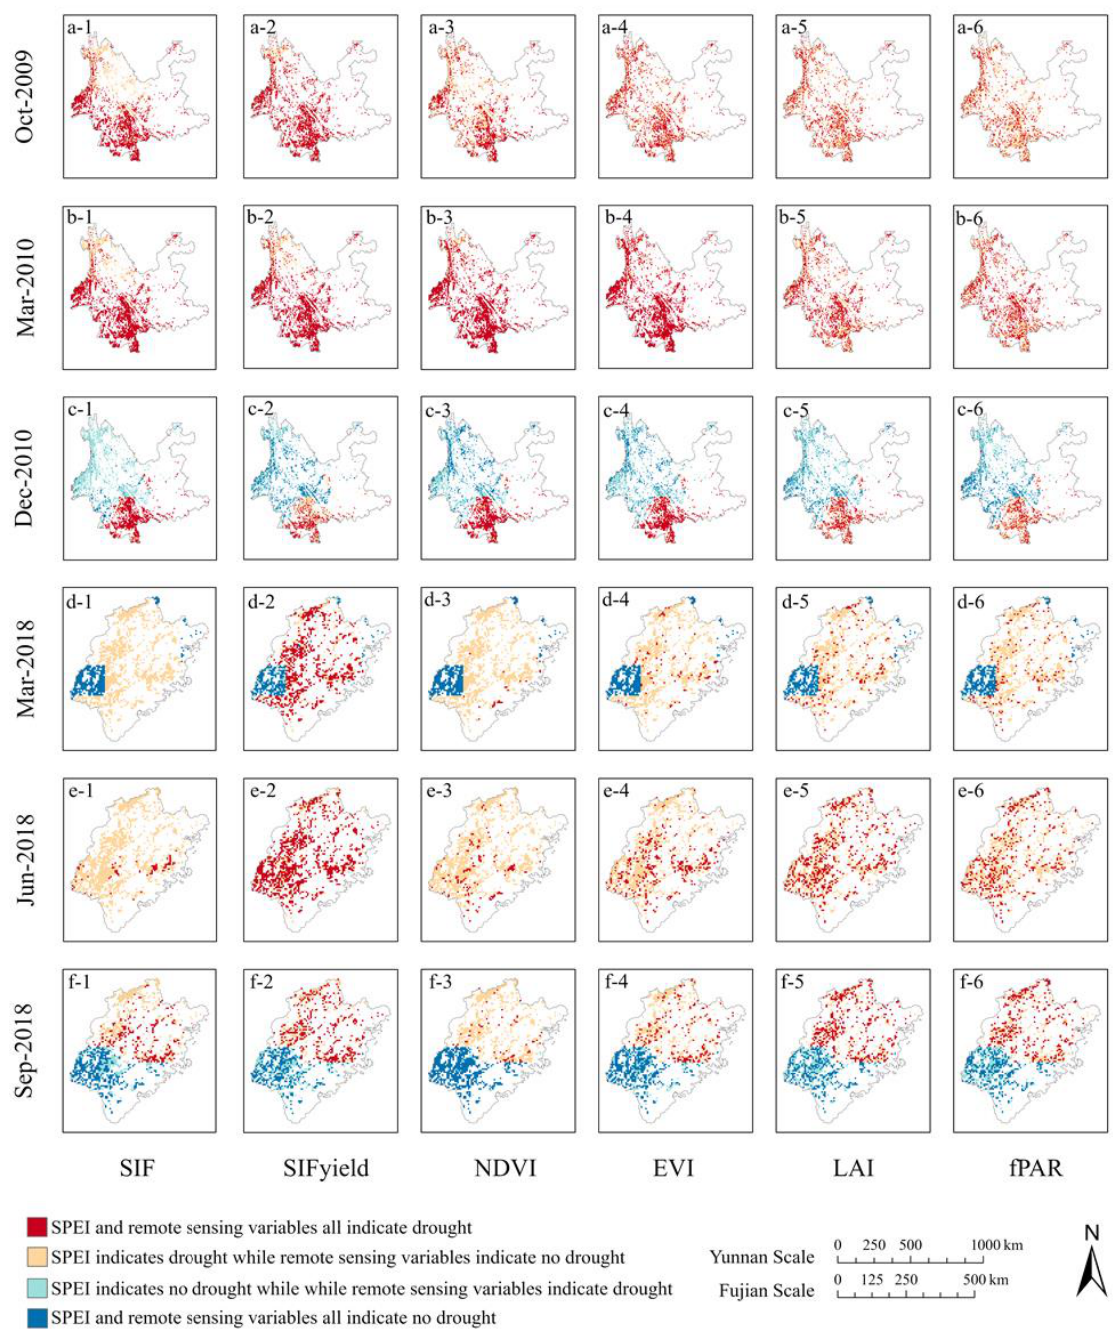
Figure 6. ( a1 – a6 ) The spatial distribution of standardized anomalies of SIF, SIFyield, NDVI, EVI, LAI, and fPAR in the early drought period in Yunnan province, respectively; ( b1 – b6 ) The spatial distribution of standardized anomalies of SIF, SIFyield, NDVI, EVI, LAI, fPAR in the middle drought period in Yunnan province, respectively; ( c1 – c6 ) The spatial distribution of standardized anomalies of SIF, SIFyield, NDVI, EVI, LAI, fPAR in the late drought period in Yunnan province, respectively; ( d1 – d6 ) The spatial distribution of standardized anomalies of SIF, SIFyield, NDVI, EVI, LAI, fPAR in the early drought period in Fujian province, respectively; ( e1 – e6 ) The spatial distribution of standardized anomalies of SIF, SIFyield, NDVI, EVI, LAI, fPAR in the middle drought period in Fujian province, respectively; ( f1 – f6 ) The spatial distribution of standardized anomalies of SIF, SIFyield, NDVI, EVI, LAI, fPAR in the late drought period in Fujian province,